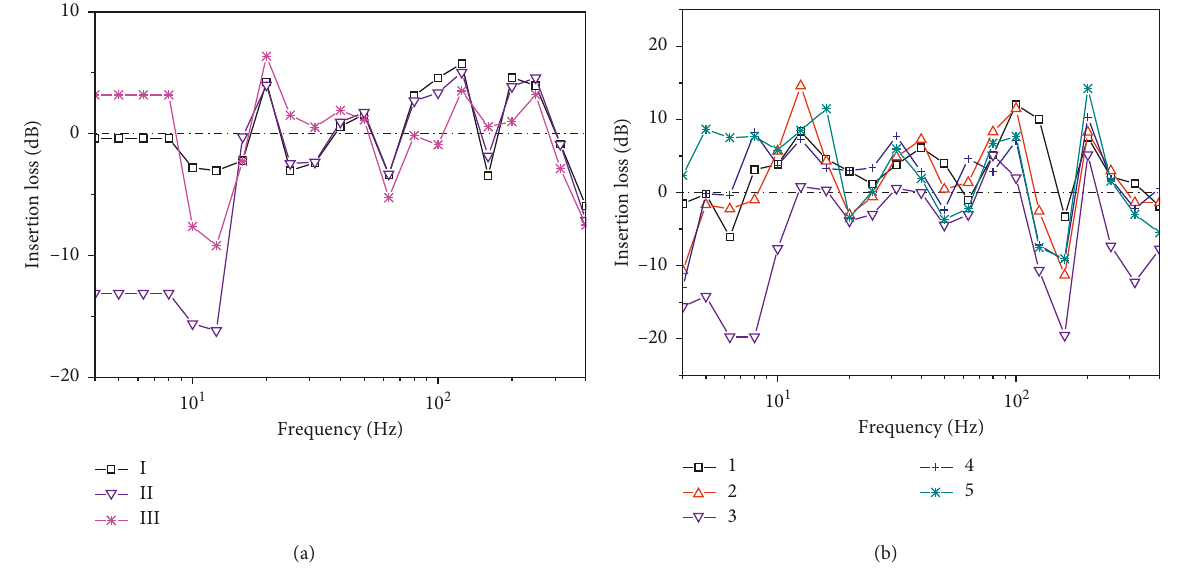
Figure 17: Insertion loss in different frequency: (a) bearing block; (b) track